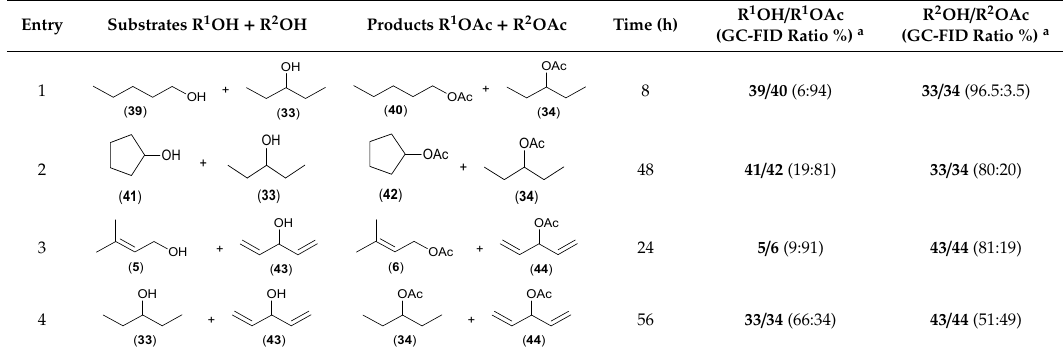
Table 2. Screening of competitive enzymatic acetylation of equimolar mixtures of alcohols according to Scheme 3.